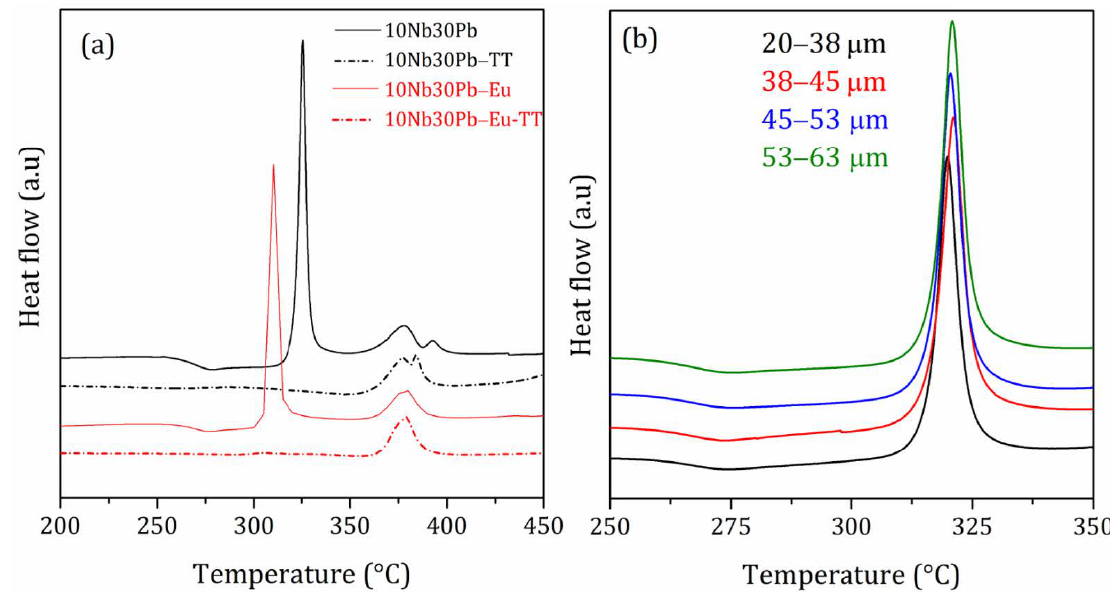
Figure 7. ( a ) DSC curves of samples 10Nb30Pb and 10Nb30Pb-Eu before and after heat-treatment and ( b ) DSC curves of sample 10Nb30Pb for different granulometries.